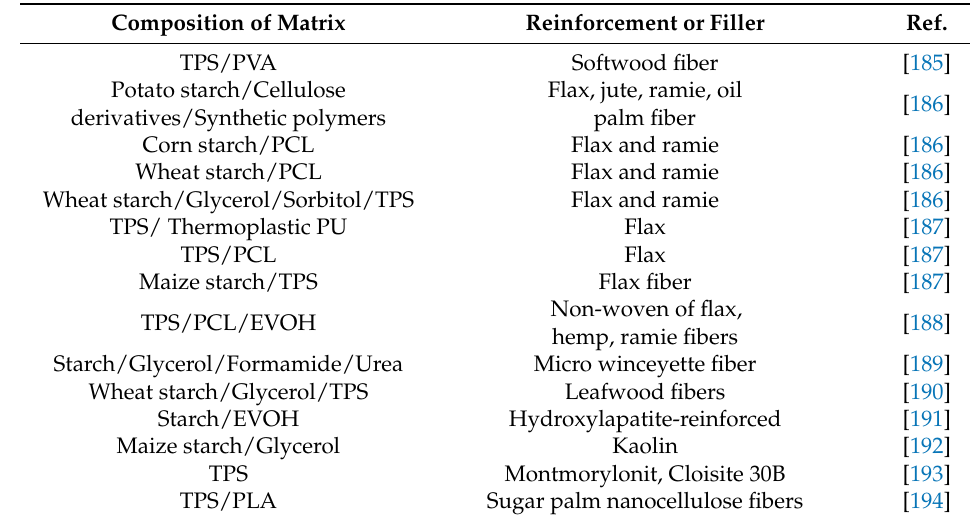
Table 7. The examples of starch/thermoplastic starch blends with reinforcements or